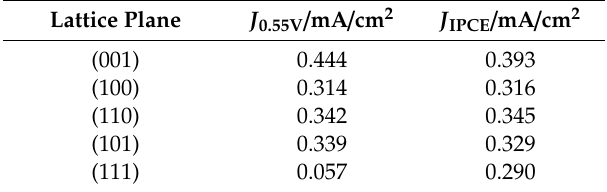
Figure 7. ( a ) Optical absorption and ( b ) IPCE spectra for the TiO 2 :Nb(001), (100), (110), (101), and (111) single-crystal substrates. The IPCE data were recorded at 1.5 V RHE in 1 M KOH electrolyte under monochromatic light illumination. Table 1. Observed J at 0.55 V RHE ( J 0.55V ) and calculated J value from the IPCE